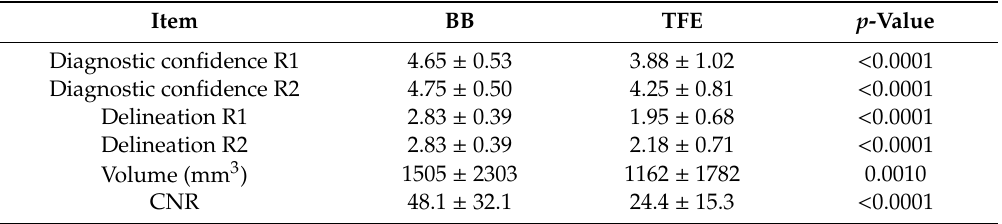
Table 2. Delineation, diagnostic confidence, volumes, and contrast-to-noise ratio (CNR) for contrast-enhancing tumor residuals in patients with incomplete resection of contrast-enhancing tumor tissue ( n = 40 patients).